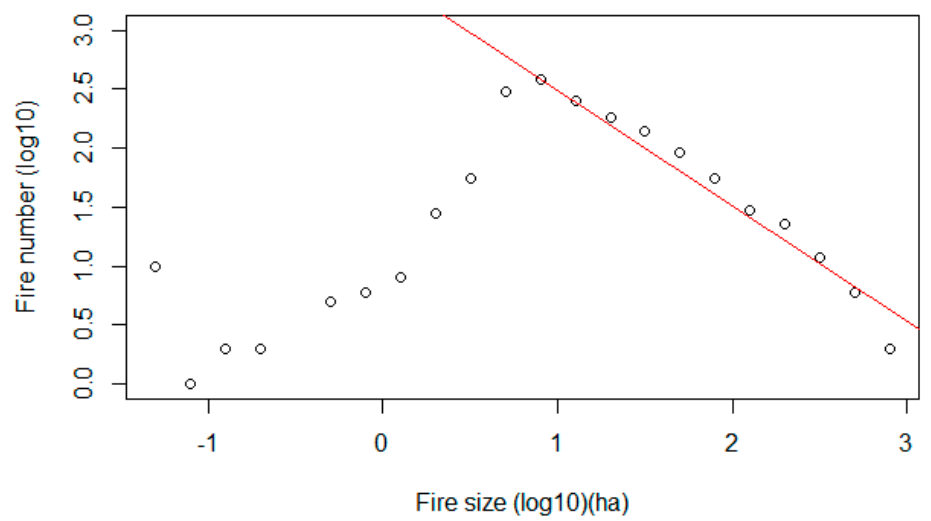
Figure 4. Fire size distribution plot for Lebanon comparing fire number (Y-axis, log10 scale) and fire size (X-axis, log 10 scale, ha). The fitted linear regression for fire size >6.3 ha (=0.8 on a log scale) is represented in red. Table 3. Yearly fire number for the period 2001–2020 in Lebanon from different sources: UOB/MoE (adapted from http://ioe-firelab.balamand.edu.lb/pages/ProfileCountryAnnex5.aspx, accessed on 1 July 2021) and the national fire inventory (Adapted from [18]) compared to our new database. NA: unavailable data.